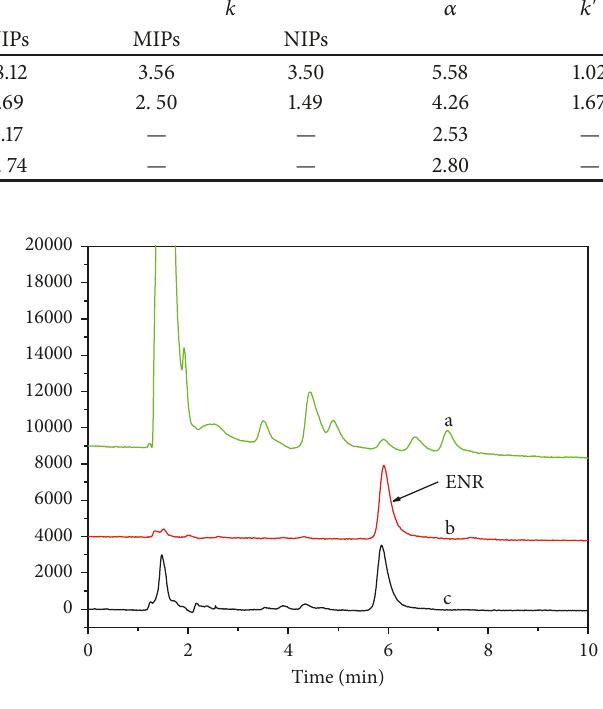
Figure 9: The chromatogram of milk samples: (a) initial milk sample, (b) sample after P GMA sample after C 18 -SPE